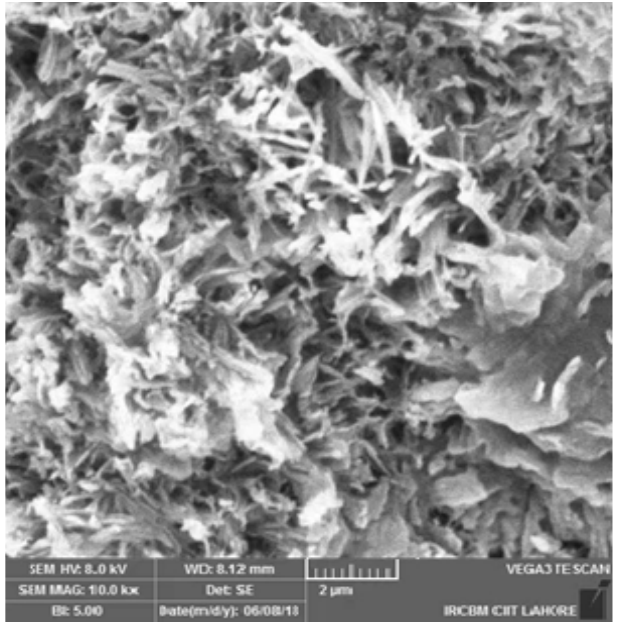
Figure 10. SEM of human hair fiber concrete.